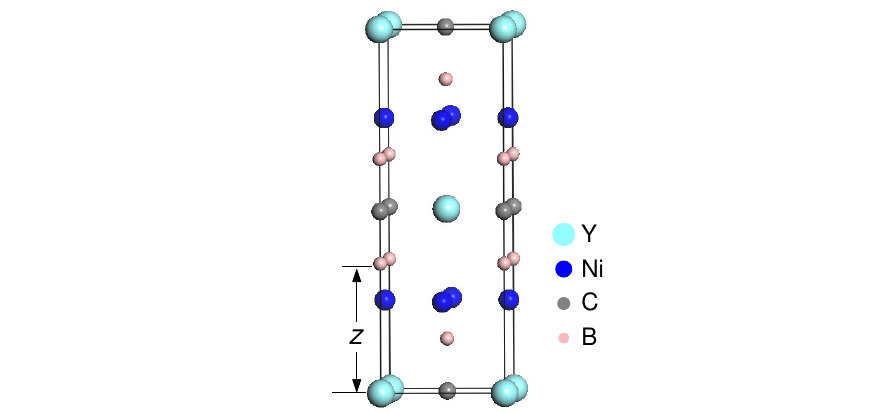
Figure 1. Crystal structure of YNi 2 B 2